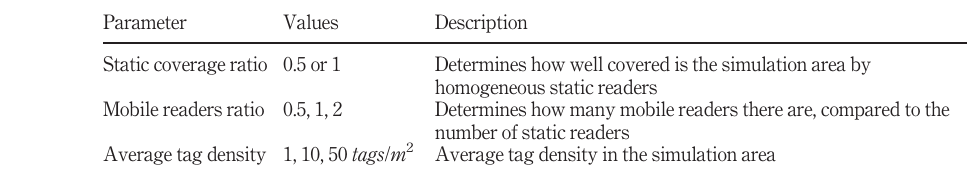
Parameter Values Description Static coverage ratio 0.5 or 1 Mobile readers ratio 0.5, 1, parameters